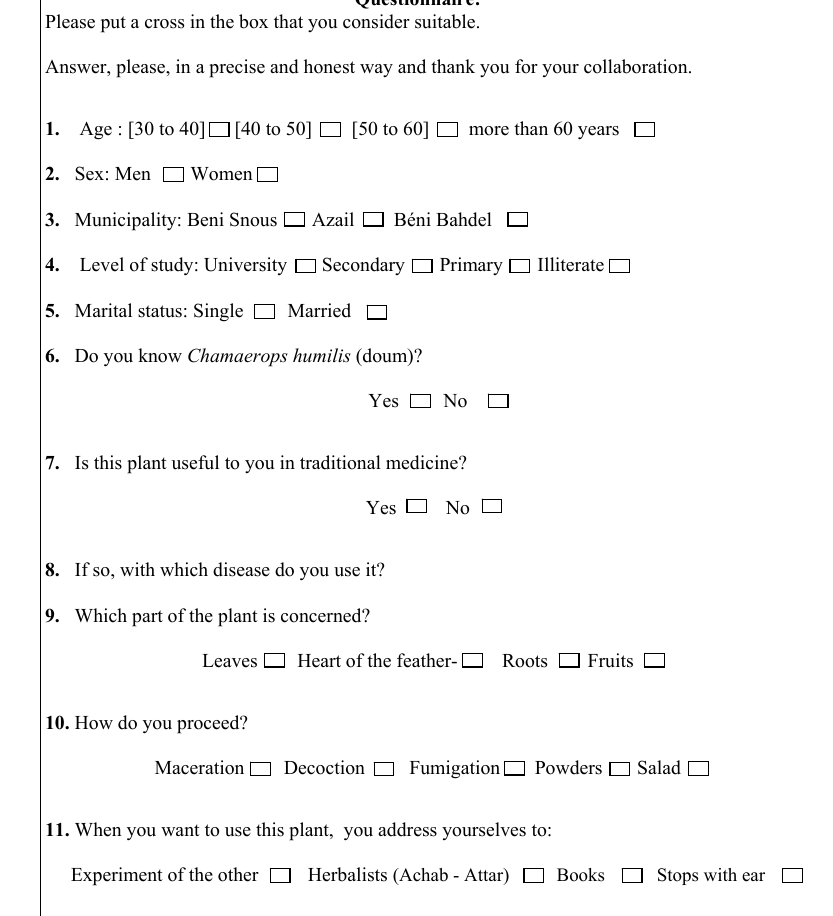
Figure 2. Questionnaire used in the ethnobotanical